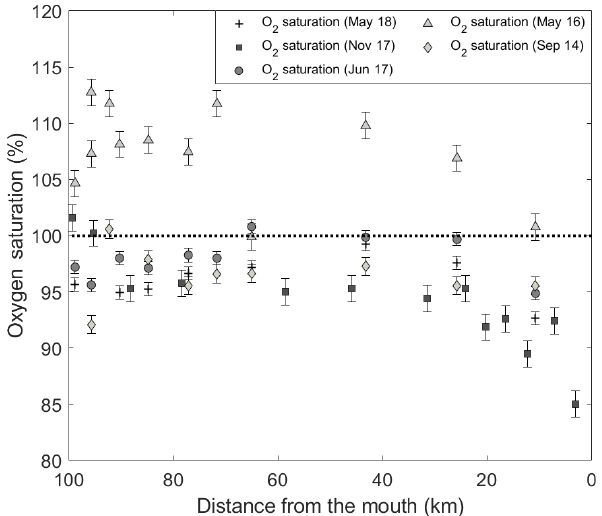
Figure 9. Spatial distribution of surface water dissolved O 2 satu- ration (%) in September 2014, May 2016, June 2017, November 2017 and May 2018. The dashed line represents equilibrium with the atmosphere (i.e., 100% saturation). Data points above the line indicate that waters are supersaturated in O 2 , whereas those below the line identify O 2 -undersaturated waters with respect to the atmo- sphere. Error bars show standard error of the mean for O 2 saturation